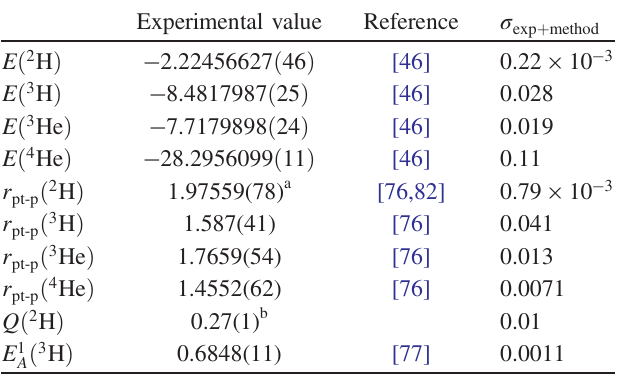
TABLE II. Experimentally determined values and uncertainties for ground-state energies (in MeV) and radii (in fm) for 2 ; 3 H and 3 ; 4 H. The quadrupole moment Q ð 2 H Þ of the deuteron is given in e fm 2 , and E A 1 denotes the reduced transition matrix element related to the β decay of 3 H. The last column gives the combined experimental and method errors. For the ground-state energies, the method error is much larger than the experimental one. Table I indicates which observables are included in the